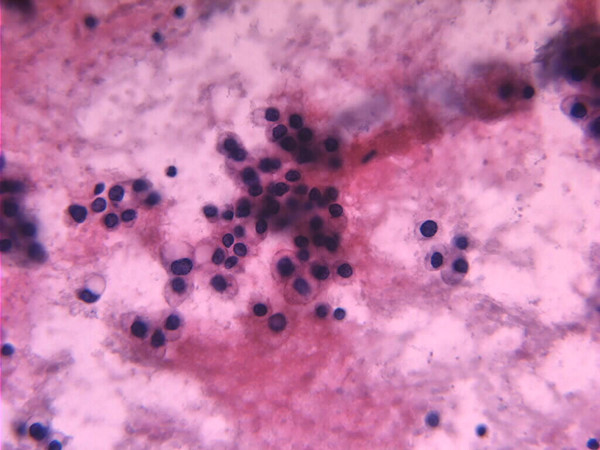
FNAC (Fine Needle Aspiration Cytology) from the mass shows polygonal cells forming microacini at places. Features consistent with Hepatocellular Carcinoma. (Papanicolaou Stain × 400)